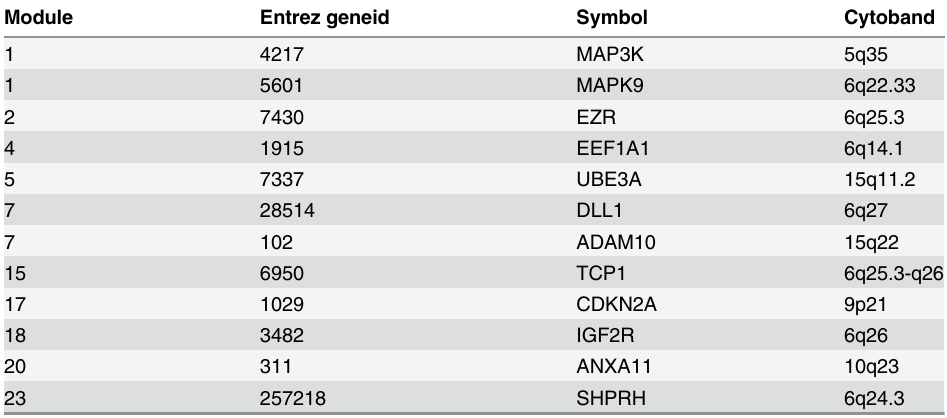
The table describes copy number associated genes with prognostic signi fi cance. For each gene, the module, the Entrez geneid, its of fi cial gene symbol, and its cytoband in the human genome (hg19) are